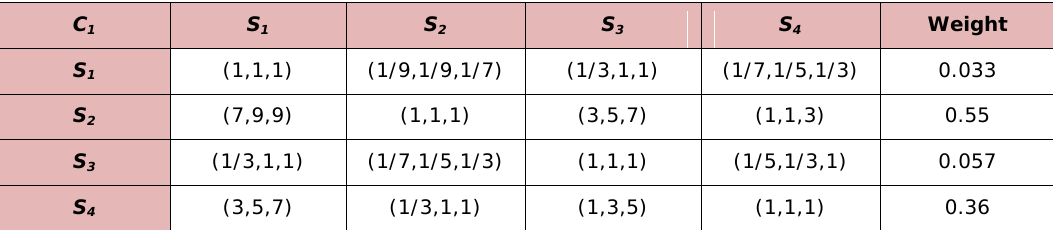
Table 3. “Fuzzy comparison matrix of the sub-criteria with respect to content quality”.